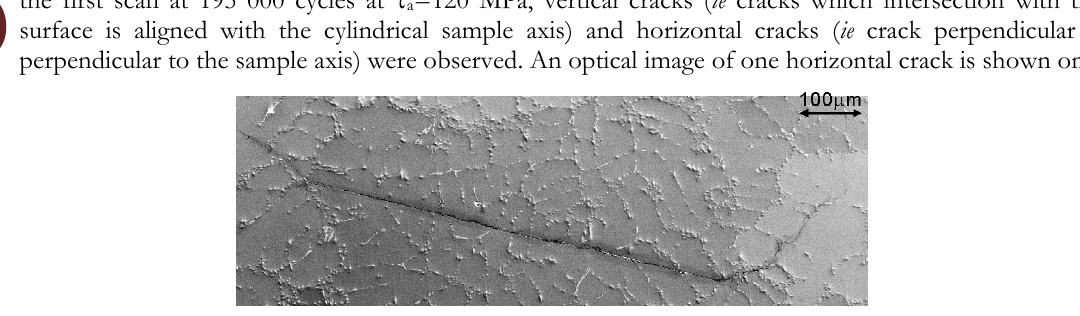
Figure 1: Optical micrograph of a mode II intragranular crack fatigue crack observed after 100 000 kcycle (  max =95 MPa). The sample axis is vertical on the figure. The plane of the crack correspond to a {111} plane the white lines show the grain boundaries with two neighbouring grains.